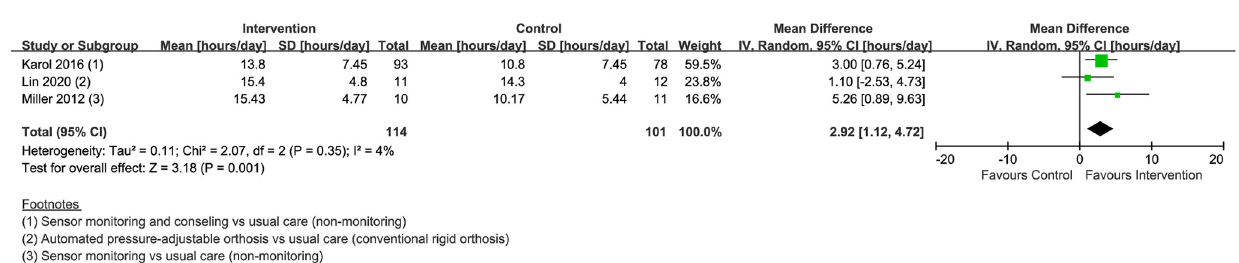
Fig 4. Forest plot of mean differences (with 95% confidence intervals) and study weights for three bracing compliance enhancing RCT studies.